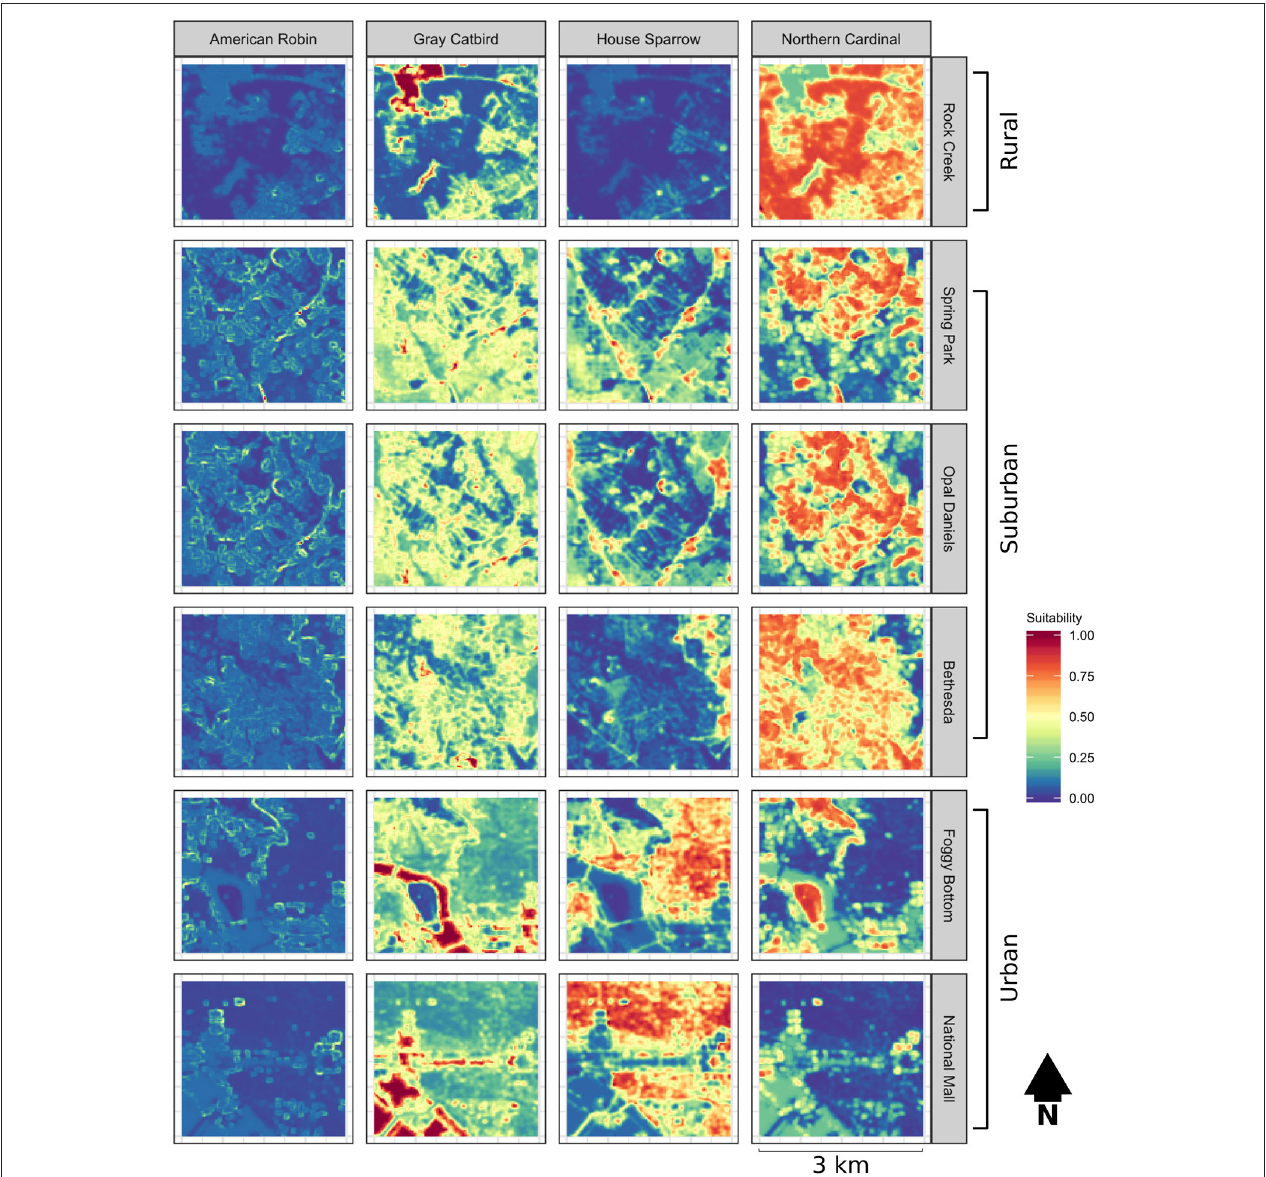
FIGURE 1 | Habitat suitability estimates obtained from point count data, scaled from 0 to 1, for sample landscapes encompassing rural, suburban, and urban habitat